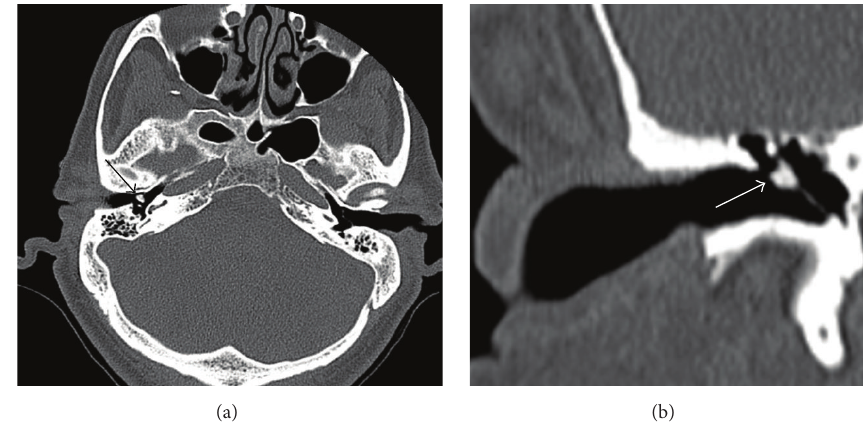
Figure 2: (a) Axial bone windowed temporal bone CT scan showing a 3-4mm hyperdense lesion (arrow); the middle ear is aerated. (b) Coronal bone windowed temporal bone CT scan showing a 3-4mm lesion lateral to the neck of the malleus (arrow). The scutum (lateral wall of epitympanum) is free of bone erosion (images courtesy of Banner University Medical Center).